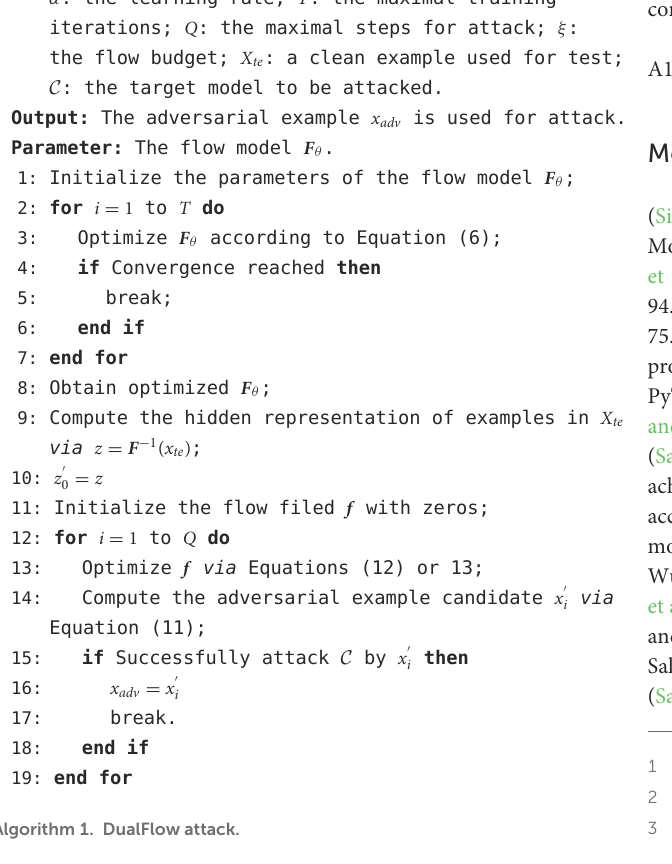
Algorithm 1. DualFlow